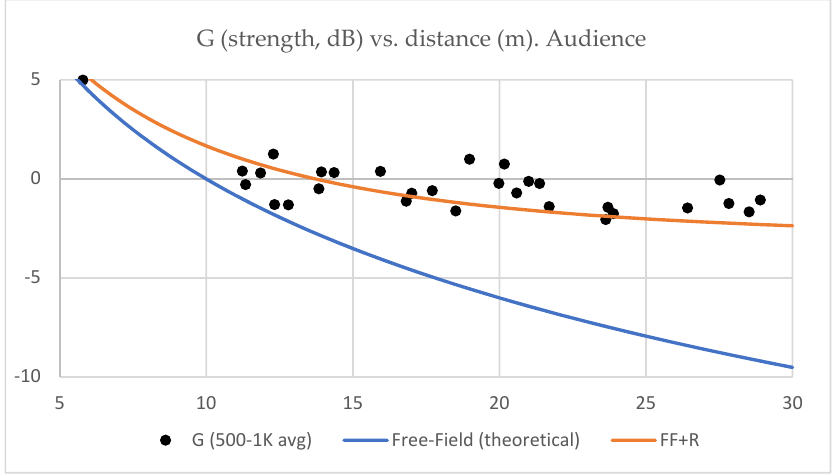
Figure 6. Gm in the audience versus source–receiver distance (m). Free-field values for comparison.